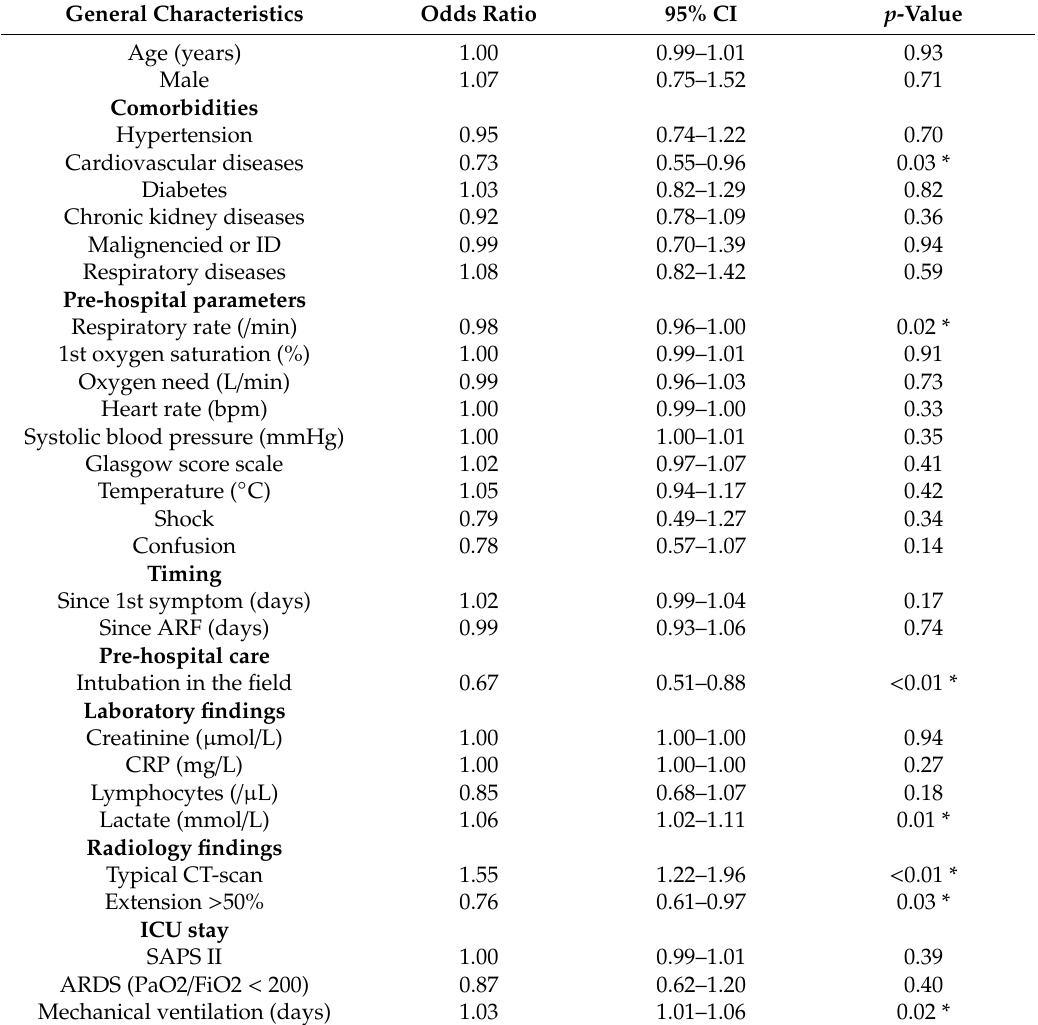
Table 3. Multivariate analysis of factors associated with the di ff erence between Type 1 and Type 2 clinical